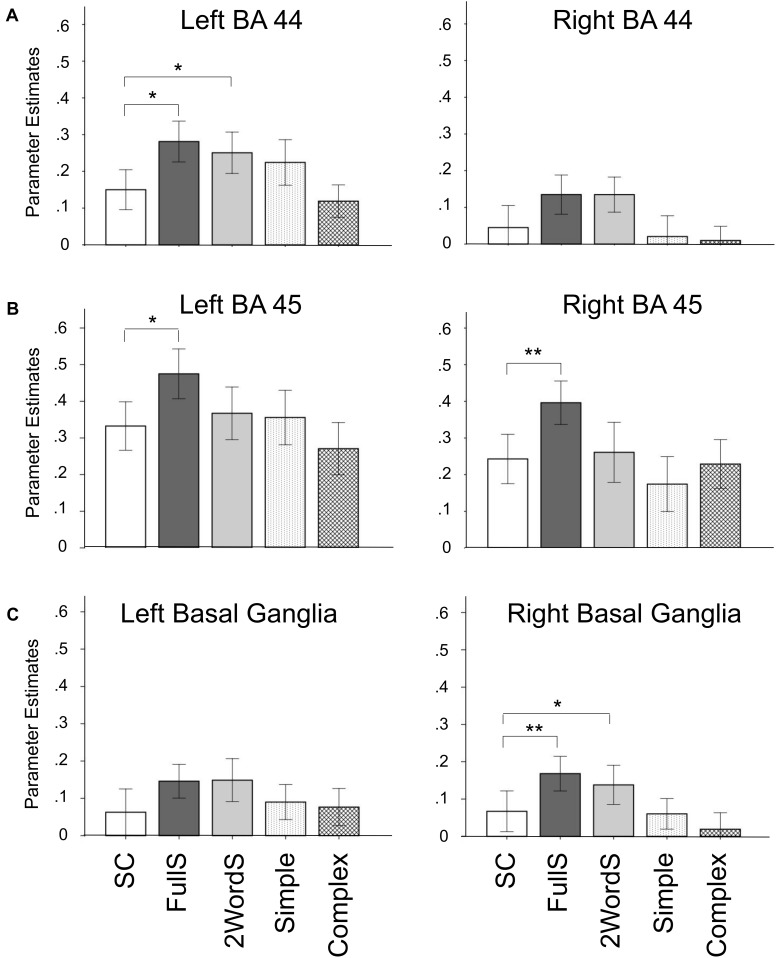
Reduced activation for Small Clause in anatomically defined syntax-related regions of interest. Parameter estimates per condition were extracted from 6 anatomically defined regions of interest and average group parameter estimates are shown by condition in bilateral BA 44 (A), BA 45 (B), and Basal Ganglia (C). ∗p < 0.05; ∗∗p < 0.02; SC, Small Clauses; FullS, Full Sentences; 2WordS, Two-word Control Sentences; Simple, Simple Compounds; Complex, Complex Compounds.